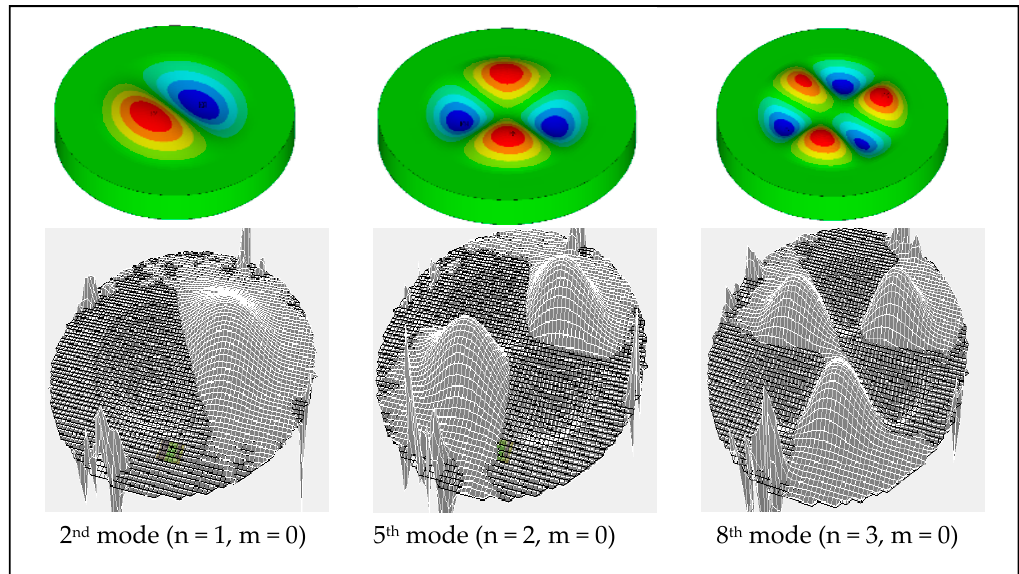
Figure 10. Examples of the experimental mode mapping.